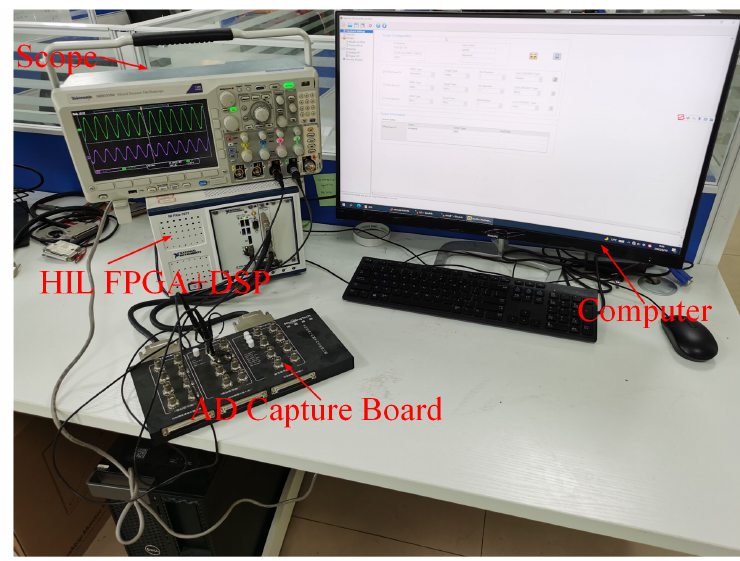
Figure 14. The hardware platform of